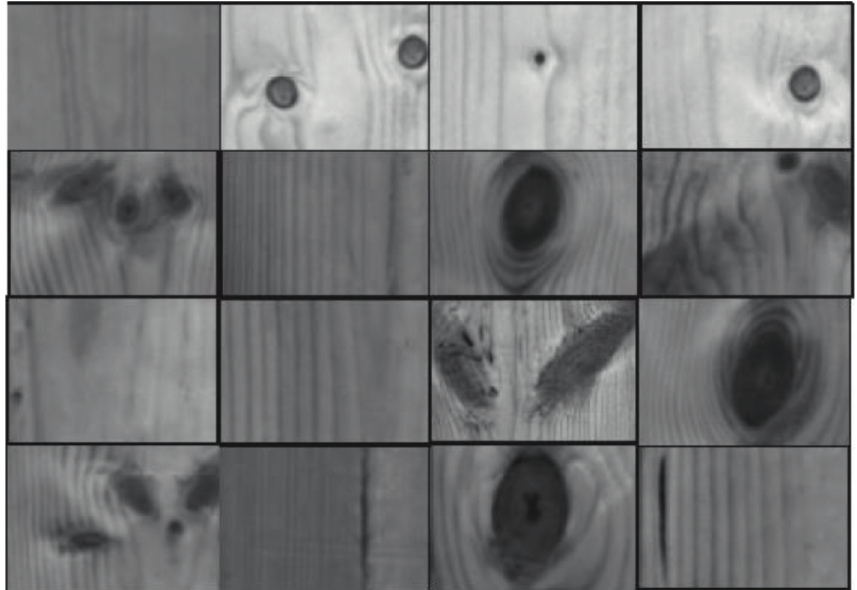
Figure 7: Design sample